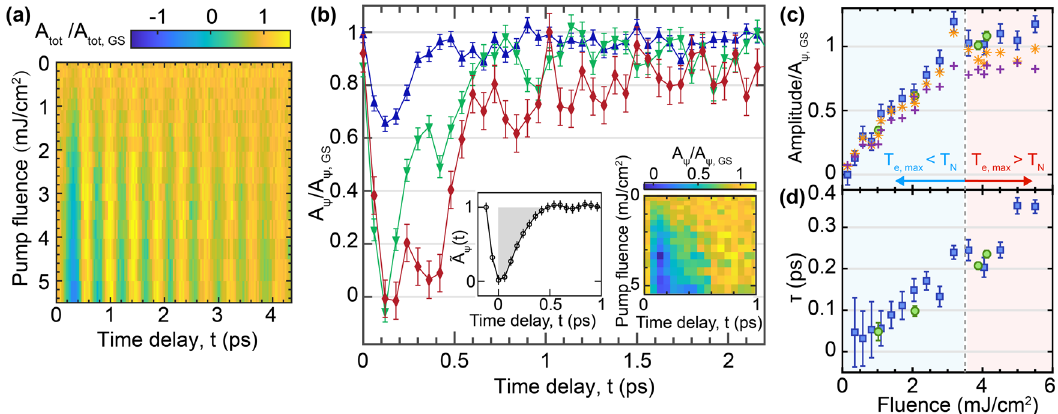
Fig. 2 Fluence-dependent phonon dynamics and electronic order recovery. a Time-resolved total displacement A tot t ð Þ normalized by the ground state (proportional to the X-ray satellite-peak intensity) as a function of the laser pump fl uence shown periodic lattice distortion (PLD) amplitude A tot t ð Þ = A tot ; GS as a color scale difference (color scale shown above the graph). b The amplitude of the transient order parameter, A ψ t ð Þ , normalized by the amplitude in the ground state, A ψ ; GS ¼ A tot ; GS , and shown for three different incident fl uences: 1 mJ/cm 2 (blue), 3 mJ/cm 2 (green), and 5 mJ/cm 2 (red). The inset shows the transient PLD amplitude for all fl uences measured in a as a color scale difference (color scale shown above the right inset). c The spin density wave (SDW) quench amount Δ A ψ ¼ A ψ 0ps ð Þ (cid:1) A ψ 0 : 1ps ð Þ (blue squares: data from a and green circles: higher statistics data) and the recovery amount (orange stars) determined from the transient PLD amplitude shown in b . The amplitude of the phonons (standing wave) A ph is also shown (magenta crosses). d The recovery time determined as the area indicated in the left inset in b , where e A ψ = [ A ψ t (cid:1) 0 : 1ps ð Þ (cid:1) A ψ 0 : 1ps ð to 1 ps. We choose the area because the exponential fi t poorly reproduces the data at higher fl uences due to the shoulder feature and the fl at region. The uncertainty in b , c , d is estimated as the standard deviation of the data at time delays above 1 ps, where we expect the residual between the harmonic oscillator fi t and the data to be